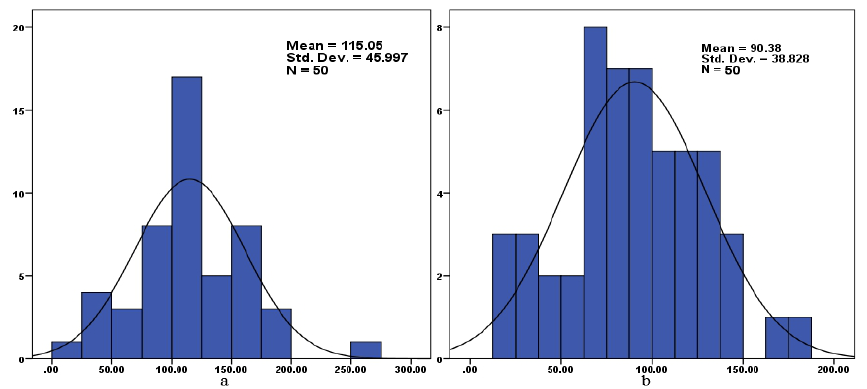
Fig. 2. Distribution of nanoparticle size: a) 1.0% molybdenum doped ZnO and b) undoped